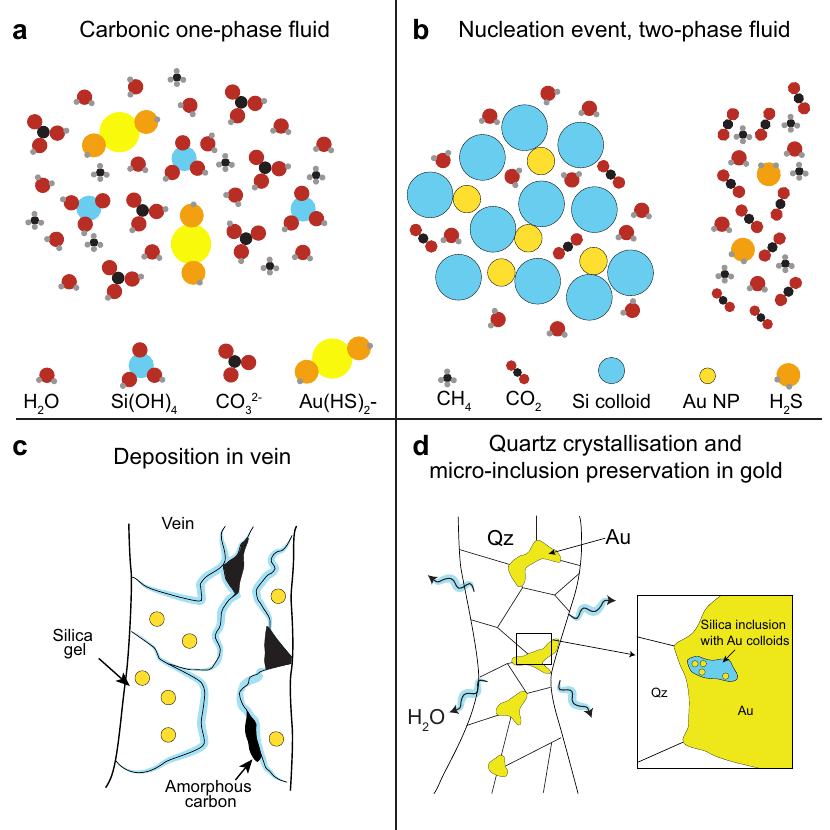
Fig. 5 Proposed model for the formation of high-grade gold veins in orogenic system. a Simpli fi ed estimated composition of a one phase aqueous carbonic fl uid initially present in the orogenic hydrothermal system prior to reaching site of deposition. The fl uid contains dissolved metal species and acid silicic. b Simpli fi ed estimated composition of a two-phase fl uid formed by fl ash vaporisation of the carbonic fl uid in a . The phase separation leads to the nucleation of silica and metals NPs. c Schematic representation of the deposition of silica gel containing metal NPs and the precipitation of amorphous carbon in the vein. d Schematic representation of the crystallisation of quartz and coarse gold in a vein from amorphous silica bearing Au NPs modi fi ed after 22 . The diagram also illustrates how NPs-bearing amorphous silica may have been trapped as inclusions in gold